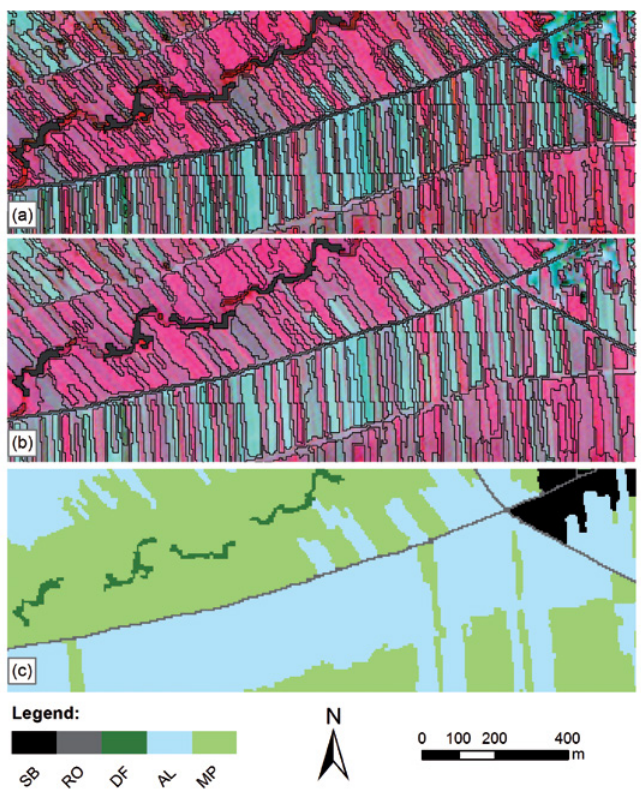
Fig. 4. classification of “Meadows and Pastures” (MP) and “arable lands” (al) using data fusion concept and knowledge-based approach: (a) – segmentation using BBre image, (b) – improved segmentation using BBre and landSat tM scenes, and final results of classification based on ndVi layers calculated from landSat TM images